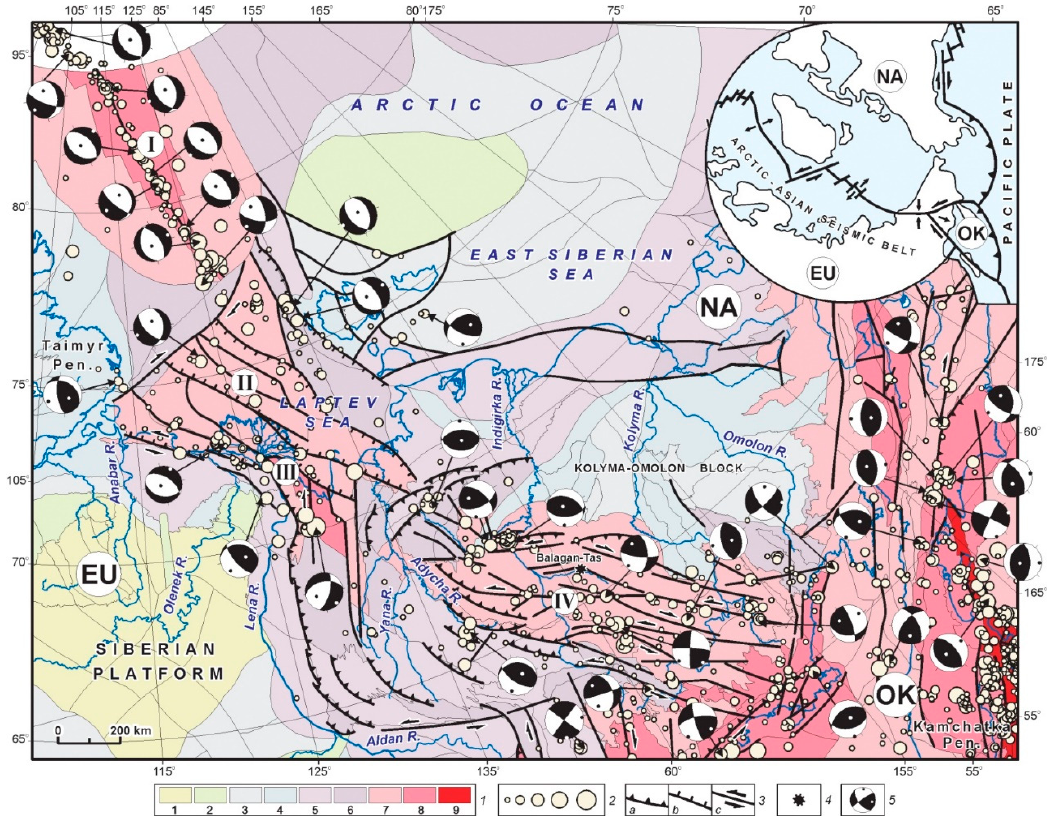
Figure 1. Geodynamic activity of neotectonic structures of the Arctic–Asian seismic belt (modified after [1]). 1—classes of geodynamic activity of the domains: 1–2—low activity, 3–5—medium activity, 6–9—high activity; 2—earthquake epicenters sized by magnitude: ≤ 4.0, 4.1–5.0, 5.1–6.0, 6.1–7.0, ≥ 7.0; 3—kinematics of active faults: (a) thrusts, (b) normal faults, (c) strike-slip faults; 4—Balagan–Tas volcano; 5—focal mechanisms of earthquakes (lower hemisphere; the principal stress axes of compression and extension are marked by black and white dots, respectively). Lithospheric plates: